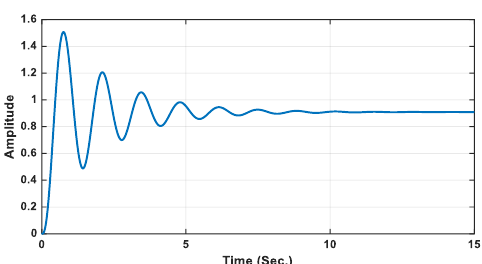
Figure 2. Step response of an AVR system without controller.